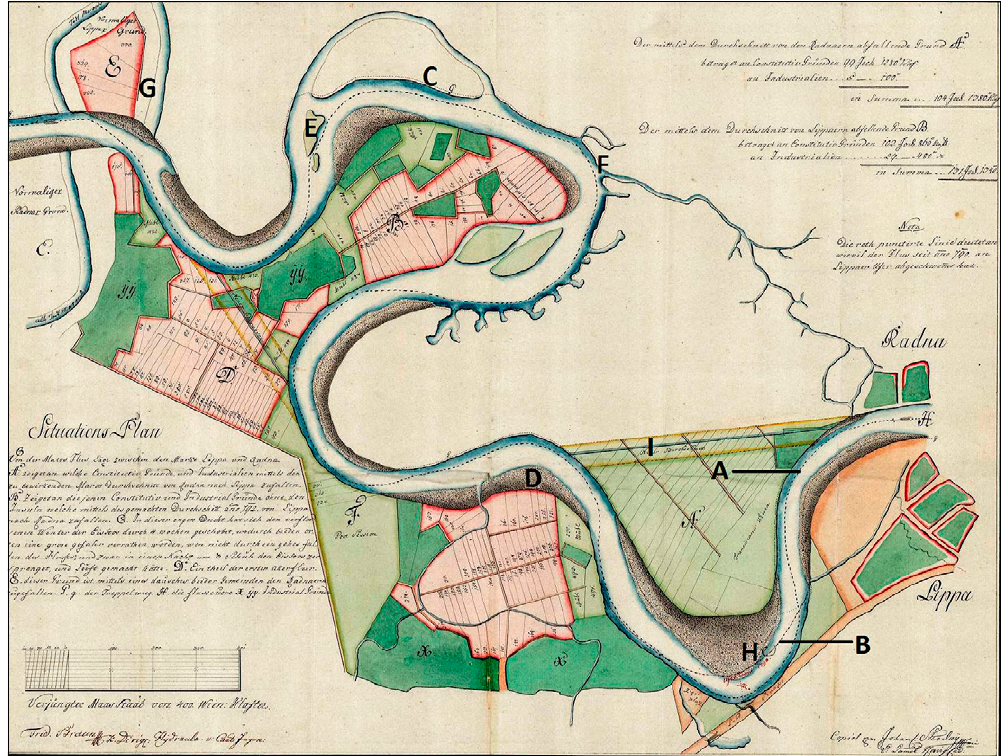
Figure 3. Situation plan of the Mureș River near Lipova city. A – thalweg; B – thalweg during floods; C – rapids; D –point bars; E – central bars; F – river tributary; G- abandoned meander; H – ice floes; I – meander correction. (Data source - https://maps.hungaricana.hu/en/MOLTerkeptar/5333/